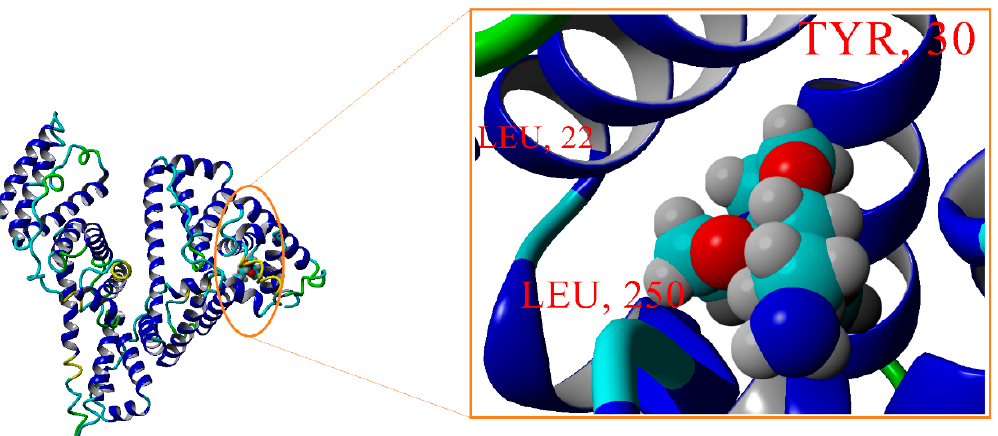
Figure 8. Molecular rendering of the best docked pose showing the interaction between HSA (receptor) and SIL M ligand; global docking view and zoom image.